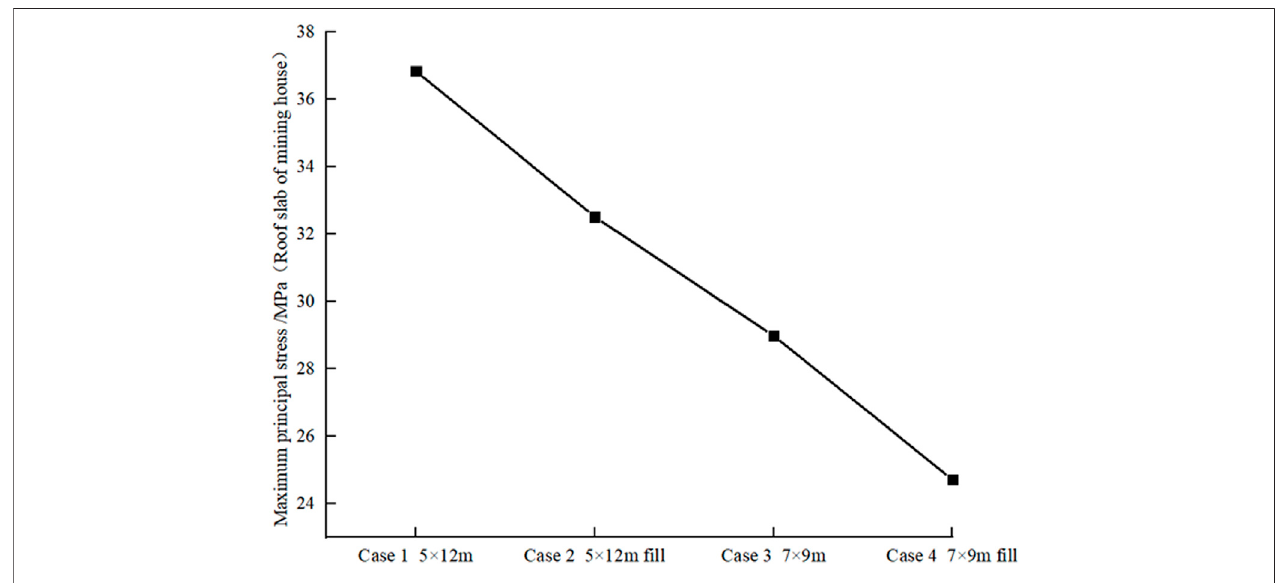
FIGURE 9 | Maximum principal stress diagram of stope roof in four case.